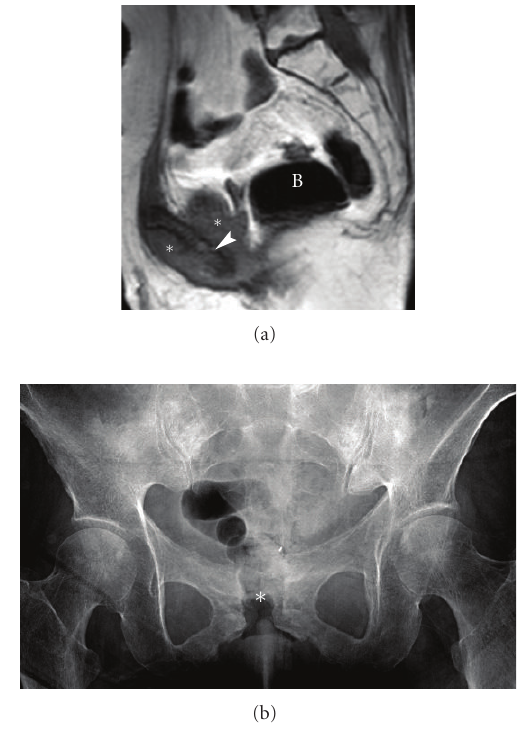
Figure 12: Pubic osteomyelitis. A 70-year-old female, with a history of previous surgery and radiotherapy for carcinoma of the cervix, presented with an open wound over the symphysis pubis. The clinical concern was the possibility of local tumor recurrence in the pubic symphysis region. The patient was subsequently diagnosed as having osteomyelitis. Sagittal T1 MRI (a) shows a soft tissue mass (asterisk) with underlying destruction of the symphysis pubis (arrowhead). Note the presence of air in the bladder (B) from a vesicovaginal fistula. Biopsy and culture proved the changes were due to osteomyelitis, rather than tumor recurrence. AP Radiograph (b) showing cortical irregularity and destruction in the region of pubic symphysis with widening of the joint (asterisk). Gas is projected within the symphysis pubis and adjacent soft tissues in keeping with the known vesicovaginal